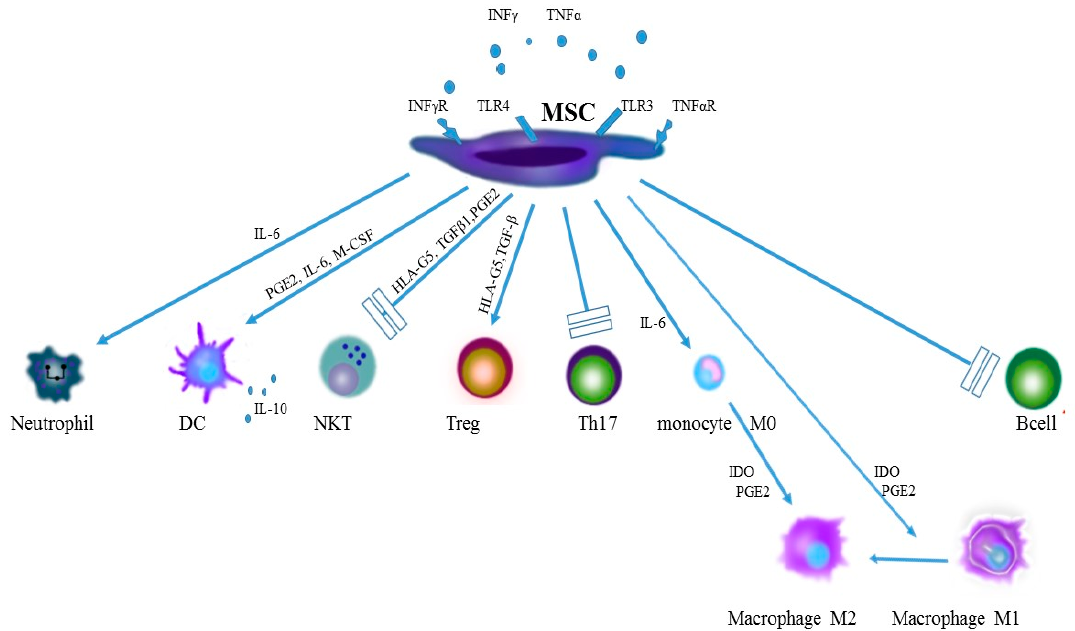
Figure 1. Immunomodulatory effect of MSC on elements of the innate and adaptive immunity systems in spondyloarthropathies. IFN- γ , interferon γ ; TNF- α , tumor necrosis factor α ; TLR,